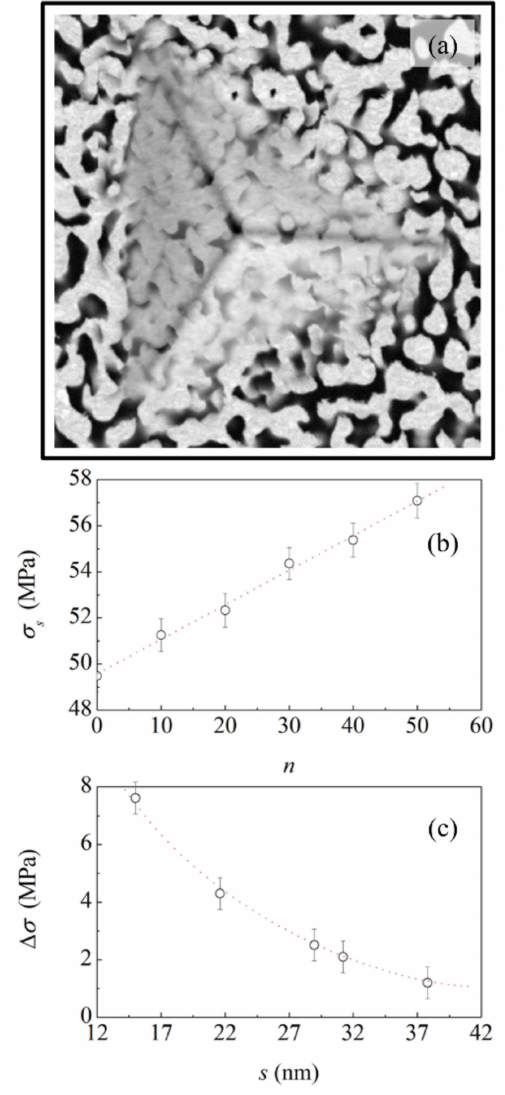
Figure 4. ( a ) SEM micrograph of the indentation area. The image refers to the NP Au structure annealed for 2 h. ( b ) The yield strength, as a function of the number of exposure cycles, n . Best-fitted line is shown. ( c ) The yield strength increase, ∆ σ , as a function of the average ligament thickness, s . The curve is a visual